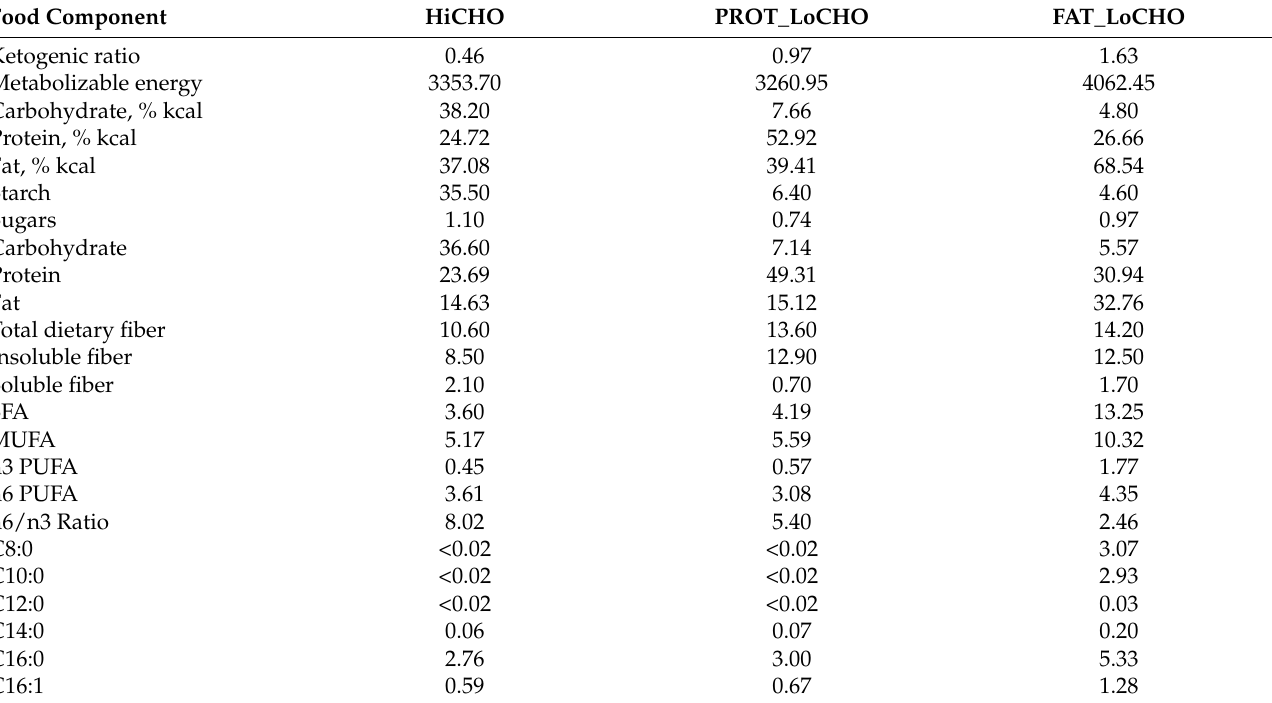
Table 1. Analyzed nutrient content of experimental